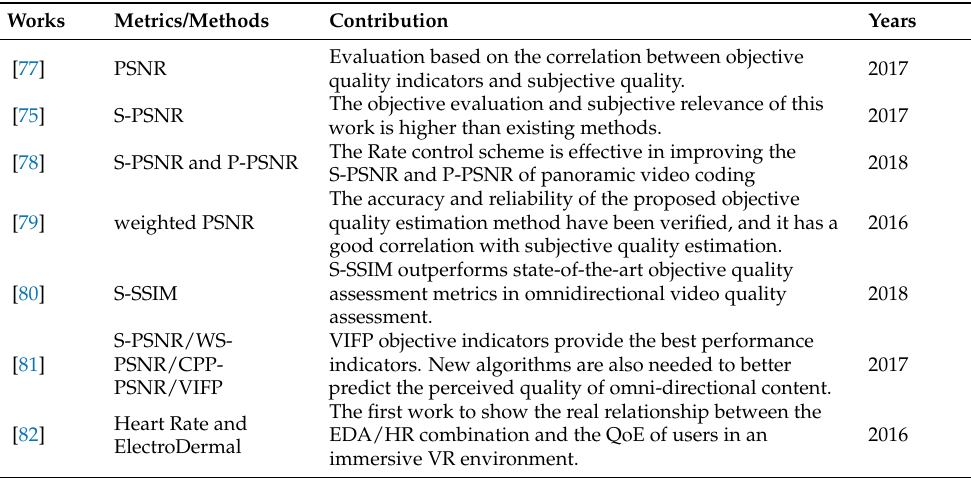
Table 4. Objective quality assessment